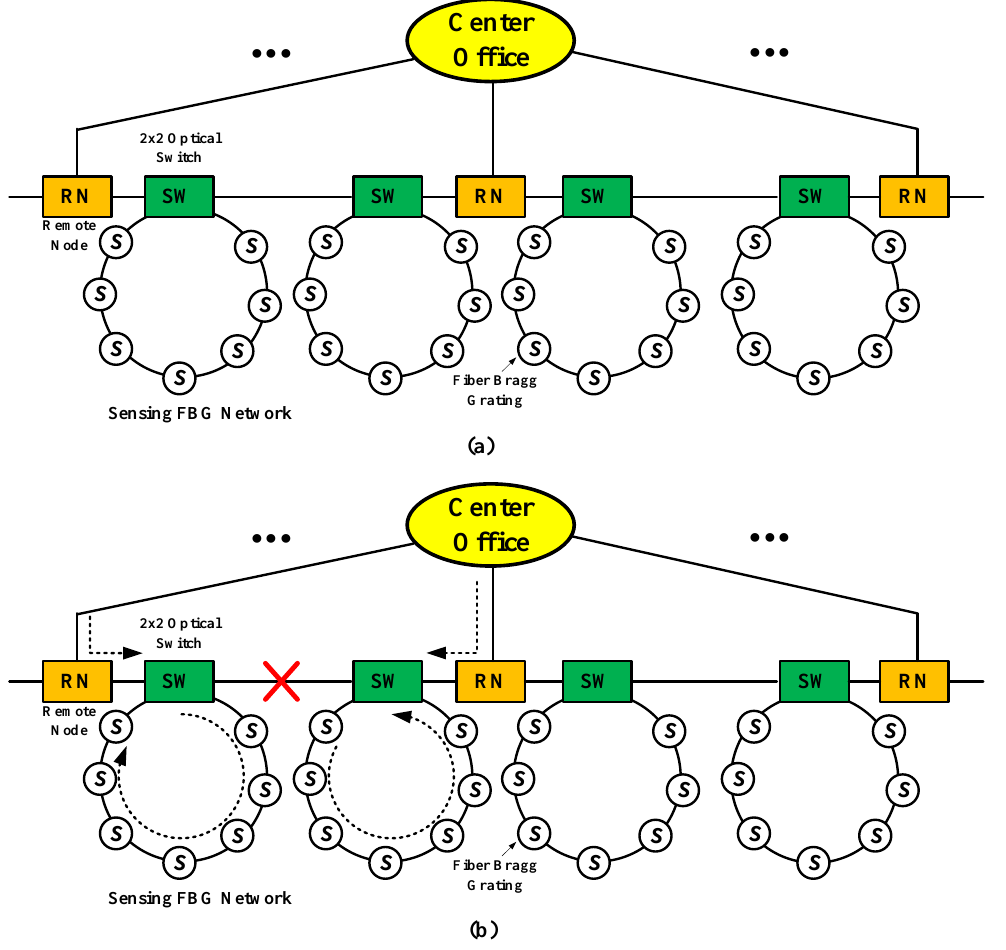
Figure 2. Self-healing architecture: ( a ) FBG sensor network; ( b ) failure in the bus subnet [46] RN: remote nodes; S: fiber Bragg grating, and SW: 2 × 2 optical switch.